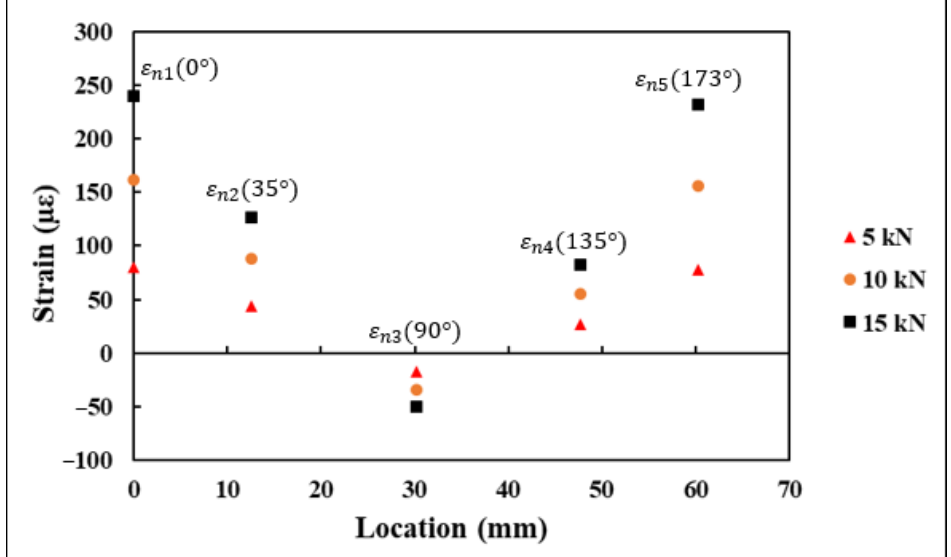
Figure 15. 𝜀 𝑛1 − 𝜀 𝑛5 transformed strains derived from strain rosette measurements.